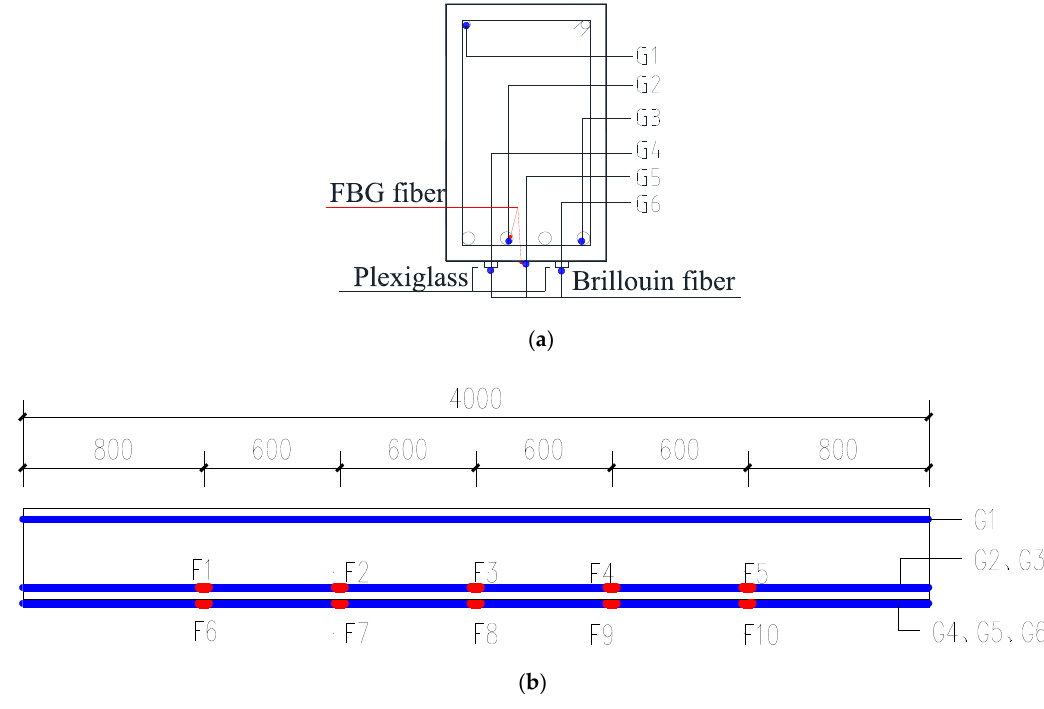
Figure 18. Layout of Brillouin and FBG optical fiber sensors ( a ) Brillouin fiber sensor ( b ) FBG sensors.